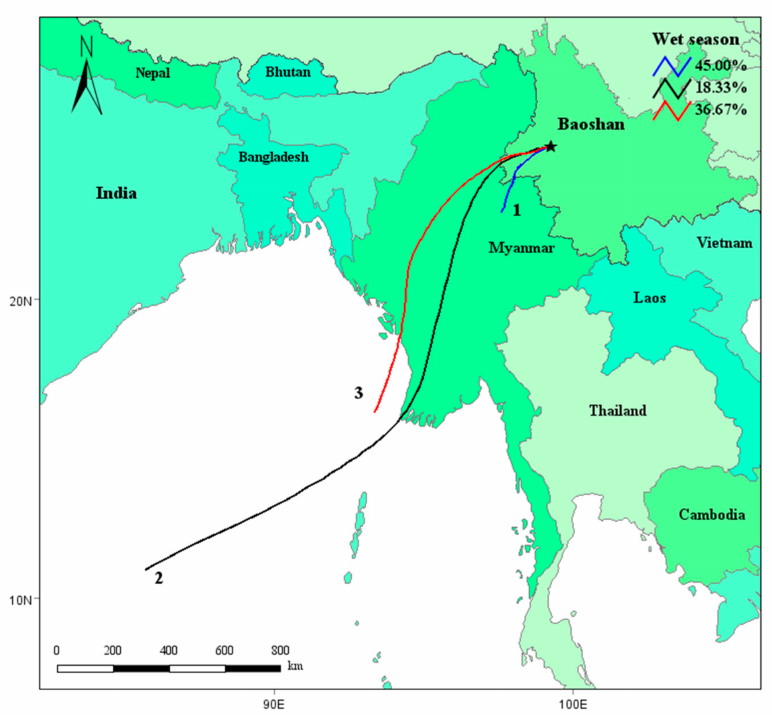
Figure 9. The mean 72 h backward trajectories of each trajectory cluster during the wet season and the percentage of allocation to each cluster.